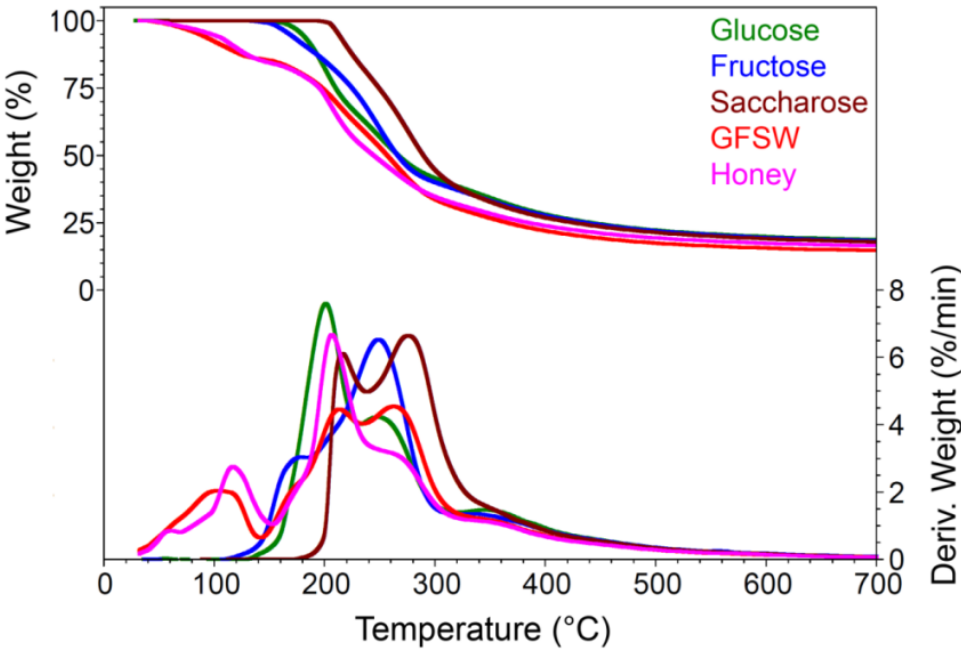
Figure 5. TGA/DTG curves of honey and DES mimetic with honey (GFSw,) and of the main components of GFSw (glucose, saccharose, fructose).